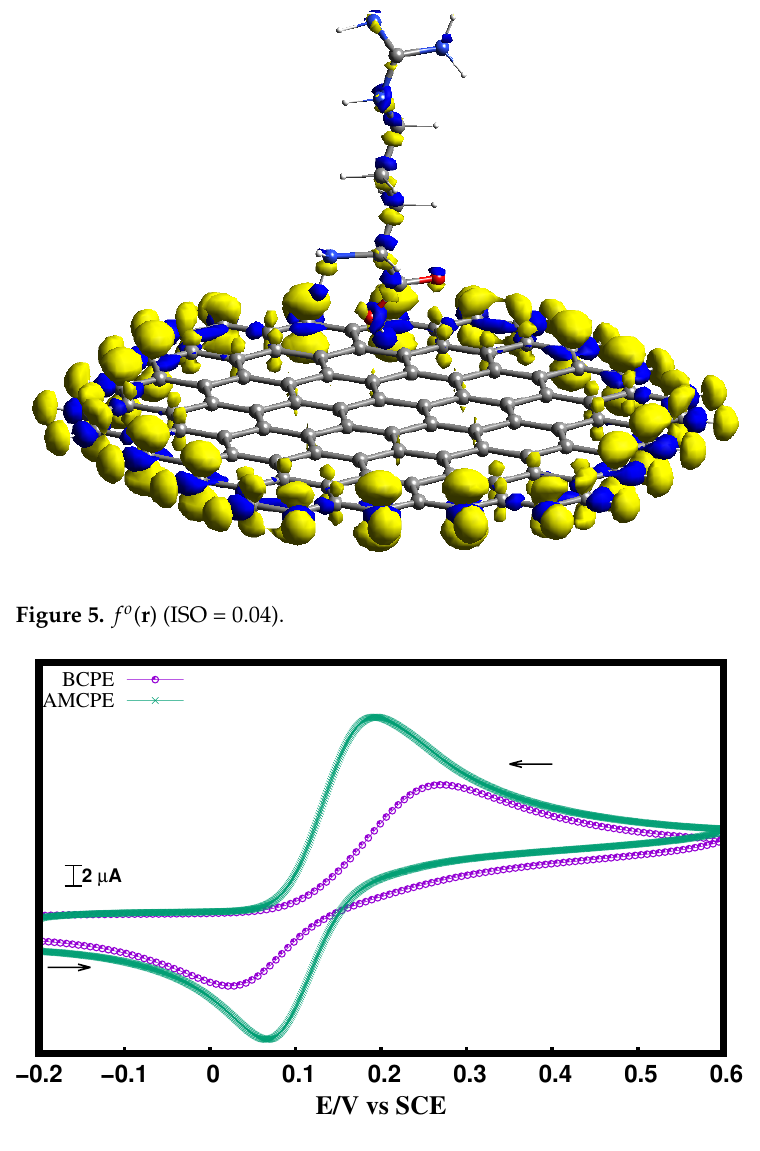
Figure 6. CV of 10 µ M DA at BCPE and